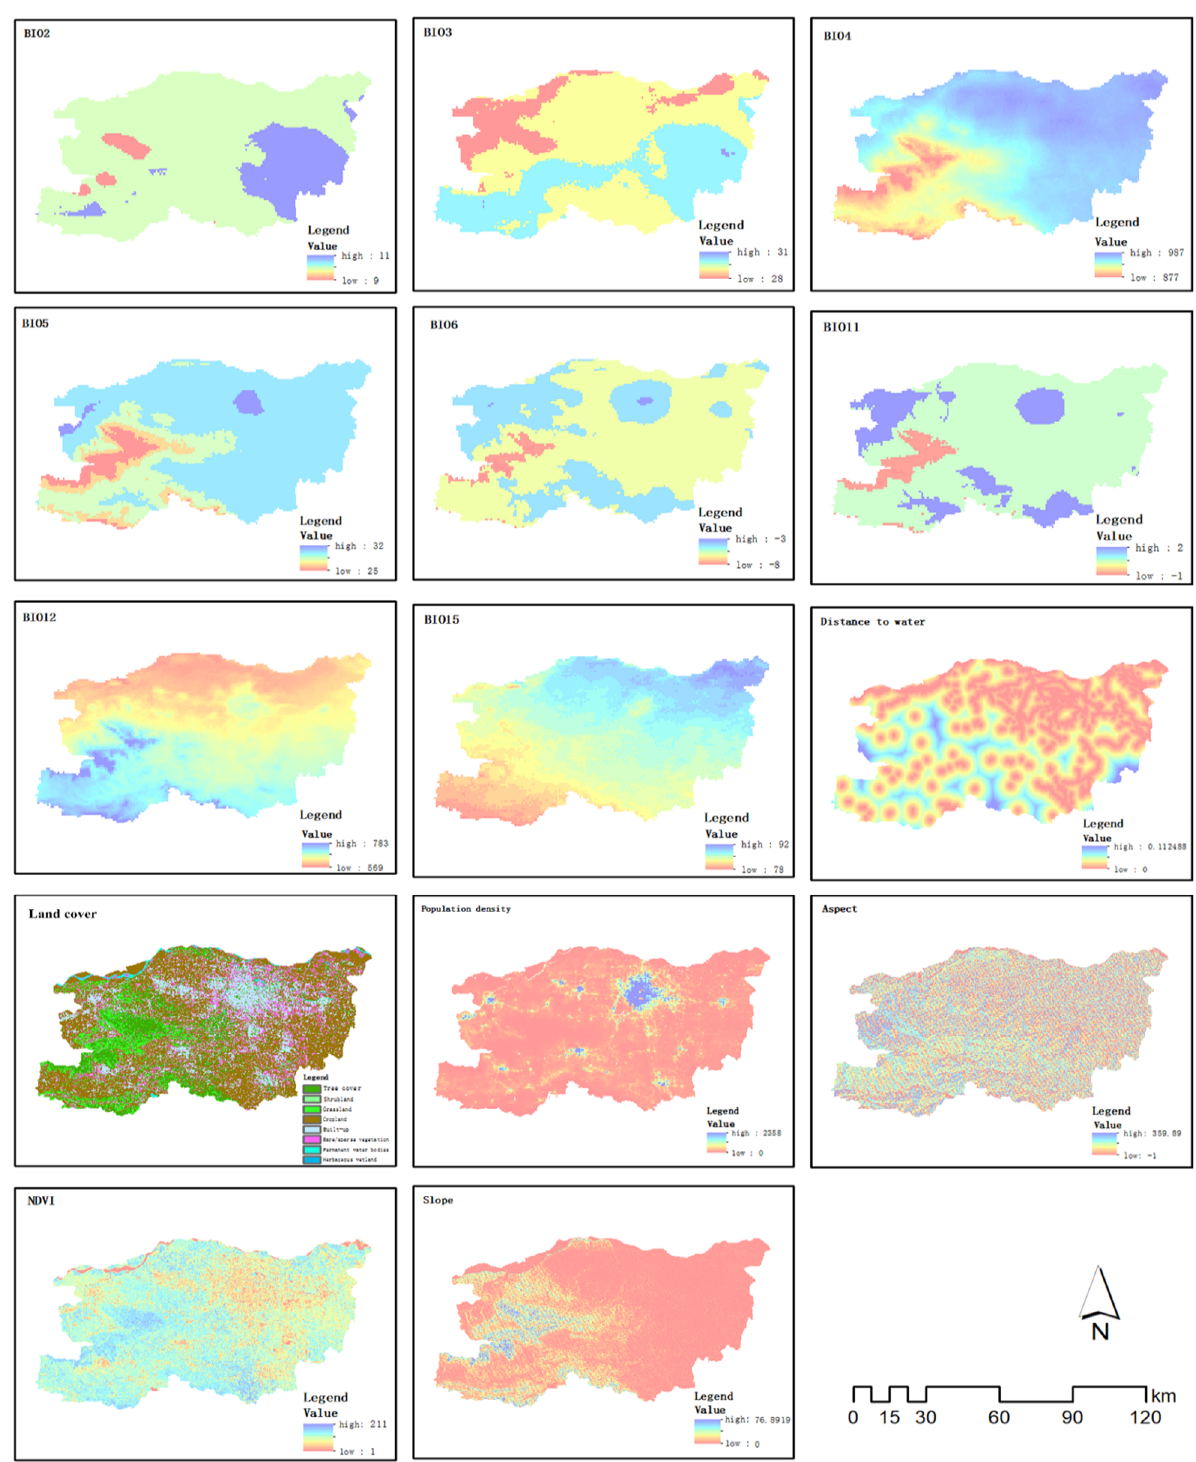
Figure A1. Raster plot of all variables involved in the model predictions.